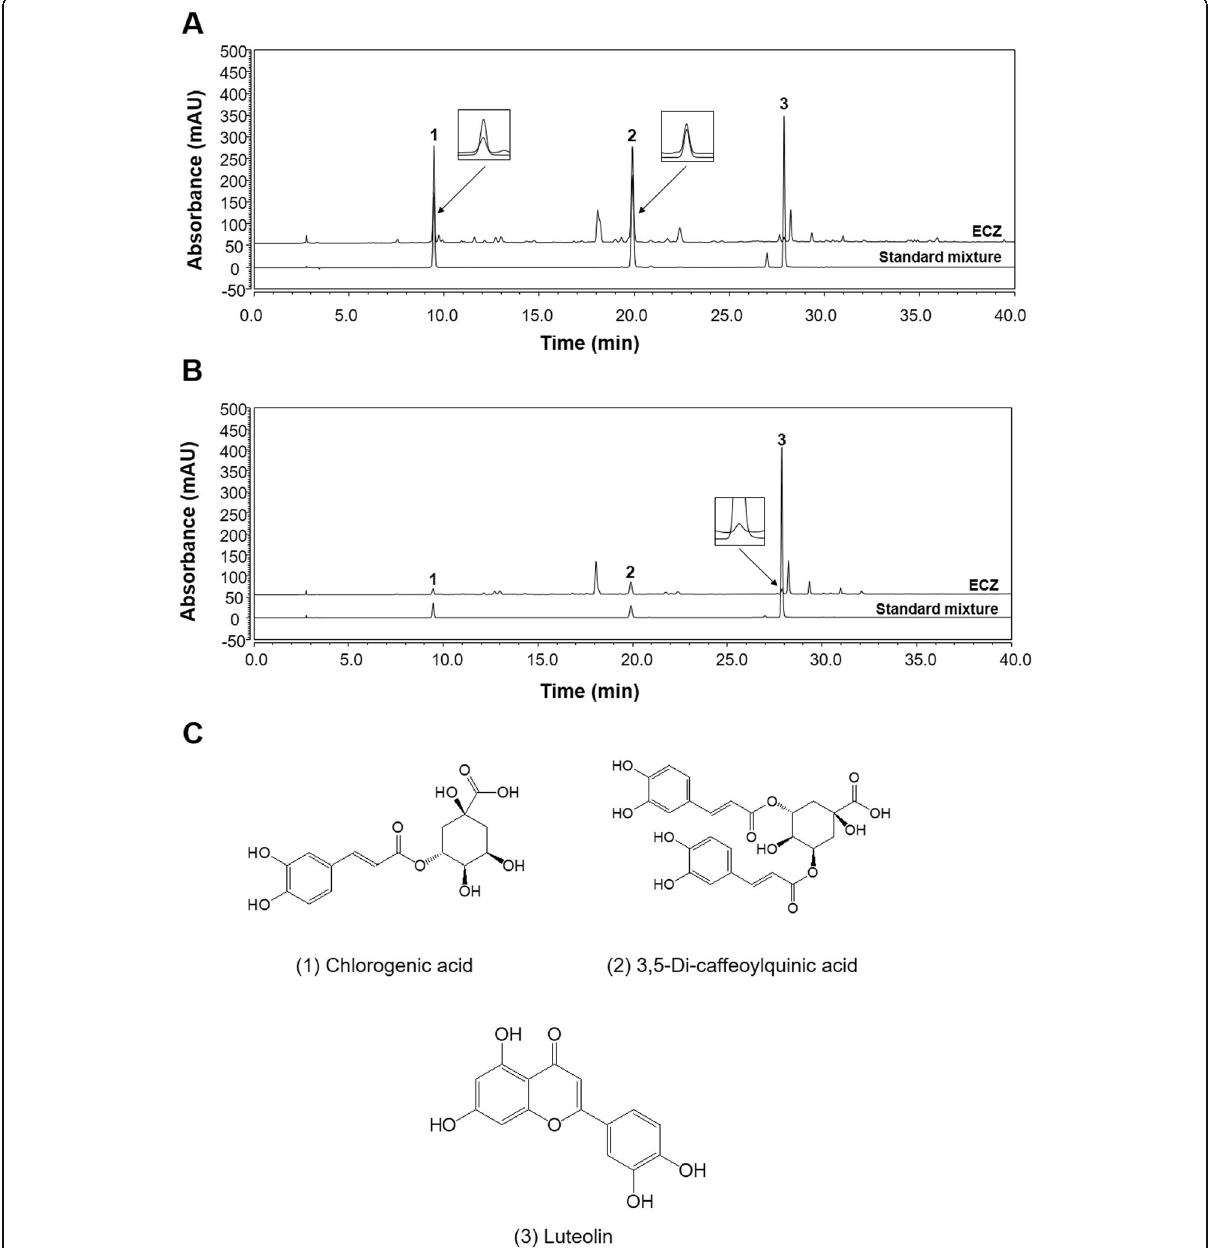
Fig. 1 High-performance liquid chromatography (HPLC) chromatograms of ethanol extracts of Chrysanthemum zawadskii Herbich (ECZ) and the chemical structures of three markers. For ECZ, the markers were identified at wavelengths of ( a ) 320 and ( b ) 365 nm by using HPLC and a diode array UV/Vis detector. c The chemical structures of three markers of ECZ. (1) chlorogenic acid, (2) 3,5-di-caffeoylquinic acid, and (3)